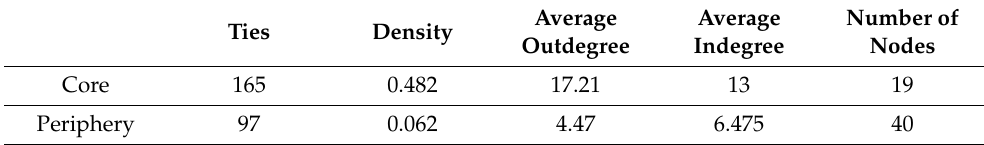
Table 2. Core and